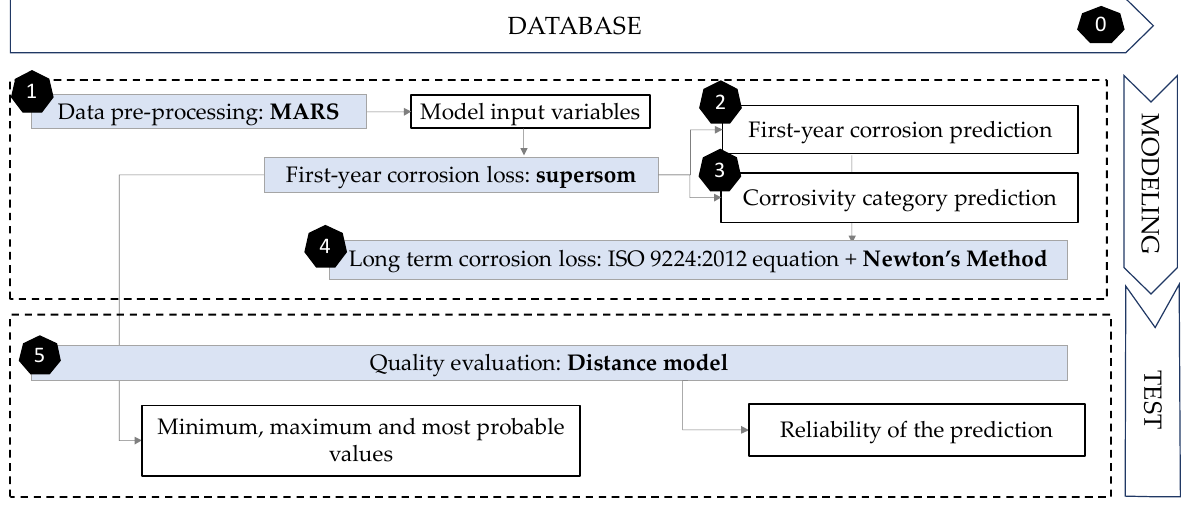
Figure 5. Flow chart showing the methodology followed in this paper. The six phases proposed are exposed as shown.